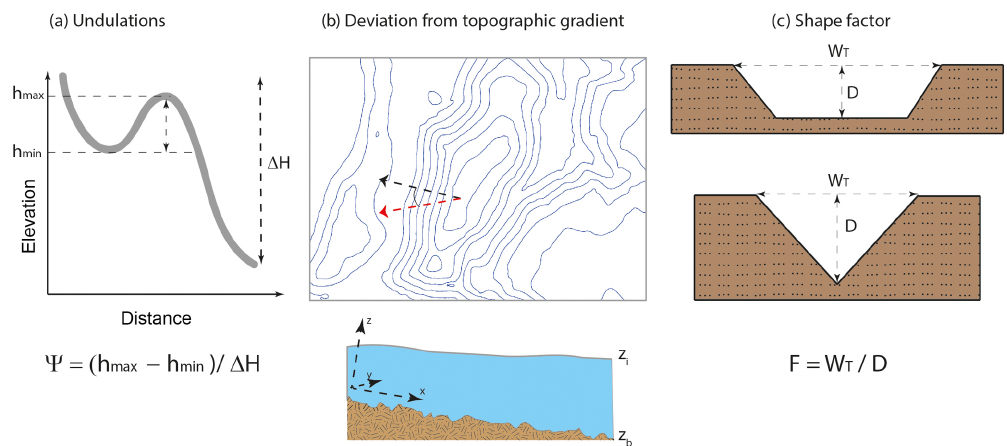
Figure 10. Illustration representing the definitions of the three remote sensing based metrics proposed in this study. (a) Shows our definition for longitudinal profile undulations (cid:57) , where the grey line represents the longitudinal profile of a channel (elevation vs. distance). (b) Repre- sents the deviation between the direction of a set of channel networks (red arrow) and the topographic gradient (black arrow), together with the axis notation and the ice and topographic surfaces z i and z b in Eq. (2). (c) Shows the definition of shape factor with two illustrations representing a trapezoidal and a V-shaped cross section, where top width W T and depth D are represented (adapted from Williams and Phillips,